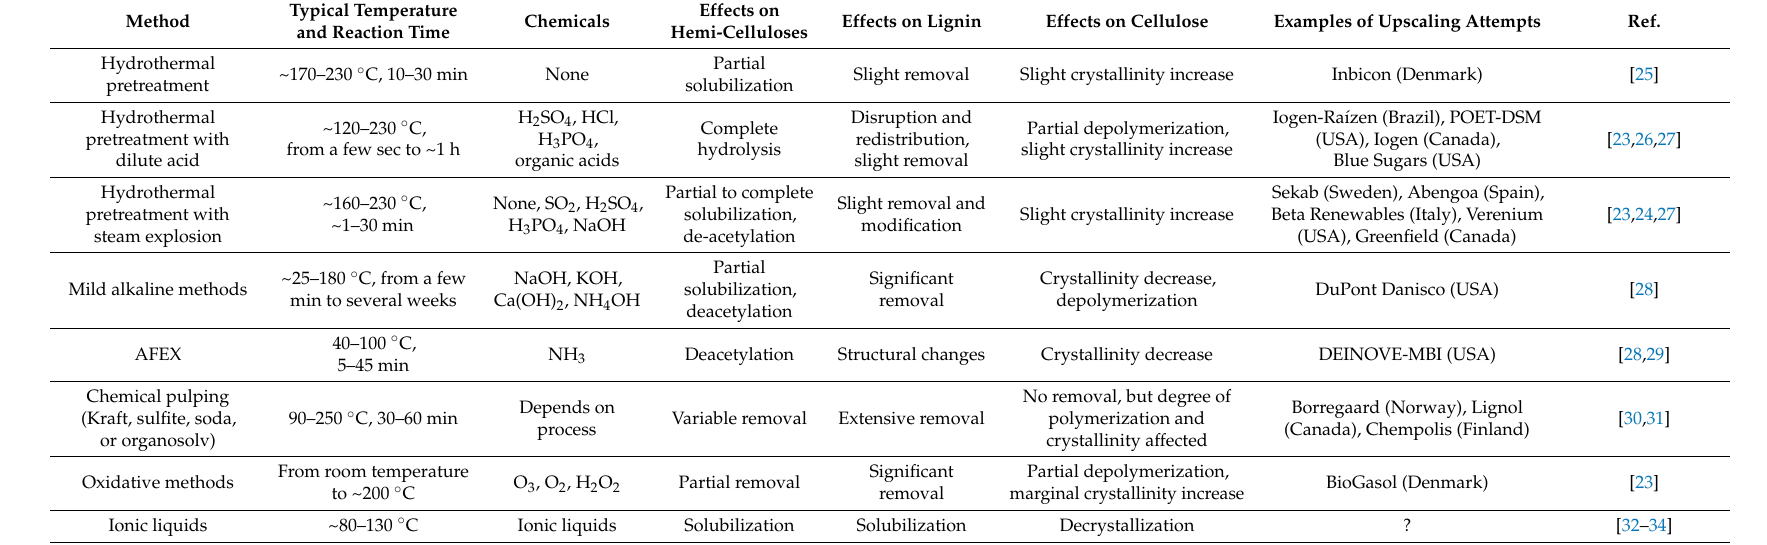
Table 1. Overview of common pretreatment